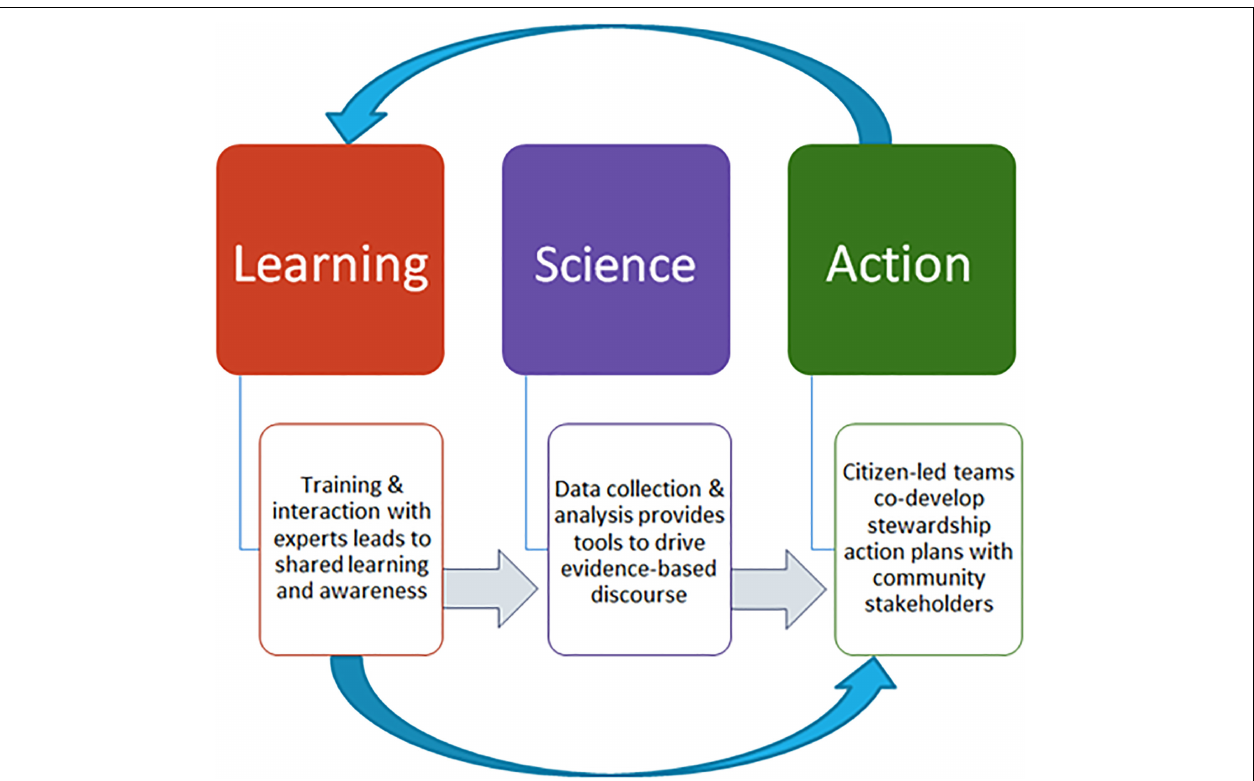
FIGURE 2 | Three areas of focus. PLACE4FEWS required a high level of participation. This figure shows the key pieces designed to engage citizen scientists (including students, retirees, and other stakeholders) to help develop a process and tools for learning about FEW nexus concepts, collecting and visualizing data, and identifying meaningful community applications and actions for